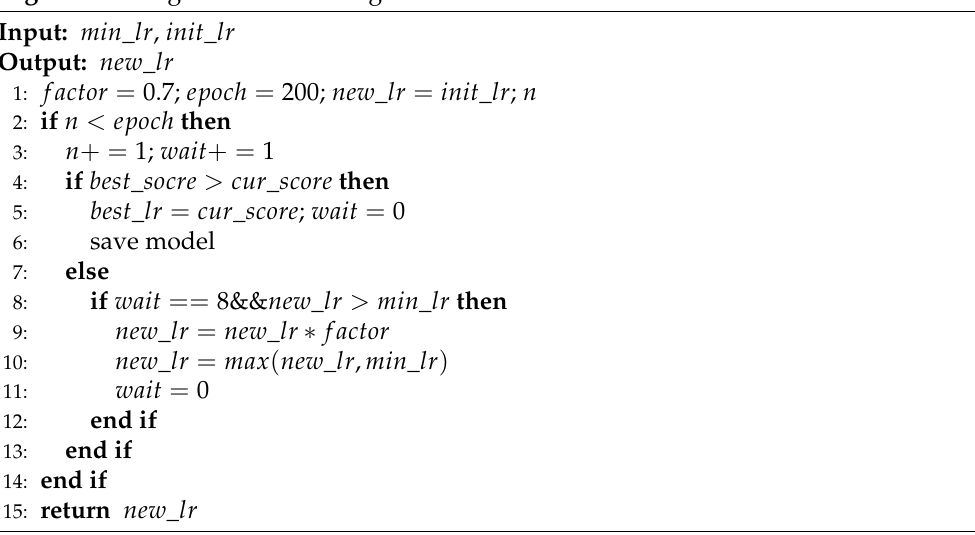
Algorithm 1 Algorithm of learning